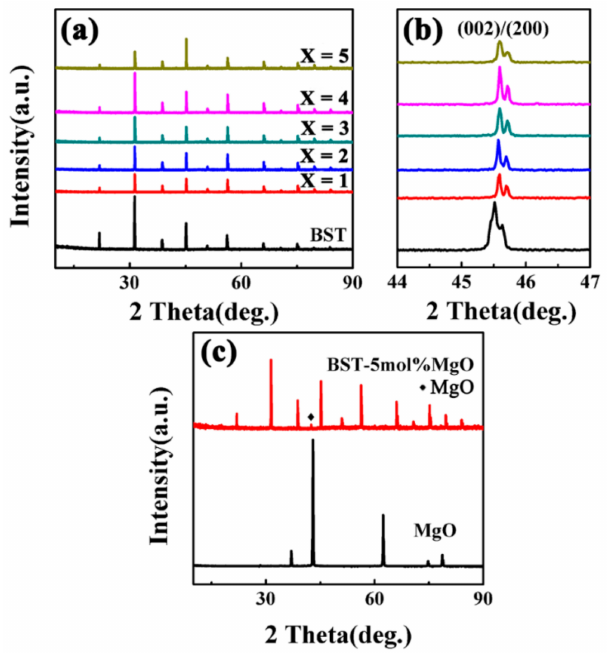
Figure 4. ( a ) XRD patterns of BST and BST- x mol% MgO ( x = 1, 2, 3, 4, 5) ceramics. ( b ) Magnification of the patterns shown in ( a ) at the range of 44 ◦ to 47 ◦ . ( c ) XRD patterns of BST-5 mol% MgO ceramic and MgO.